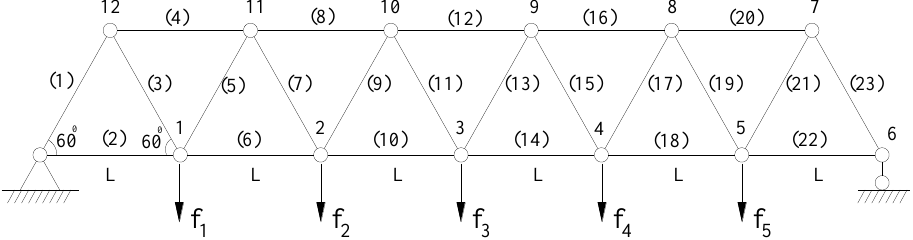
Figure 1. An initial structure of a 23-bar truss. Material parameters: Elastic modulus is 200 GPa, density is 7800 kg/m 3 , L = 1 m, and initial cross-sectional area of each bar is 175.9 mm 2 .